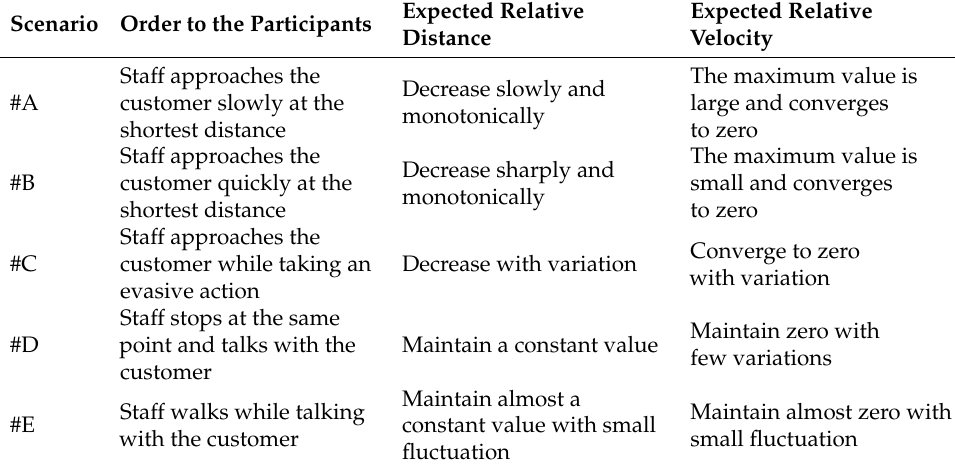
Table 2. Five configured operational scenarios and physical